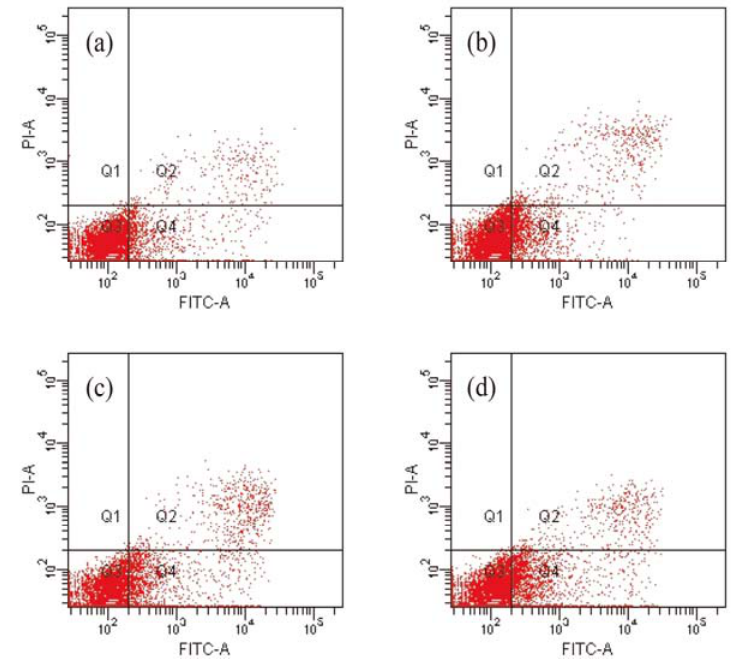
Figure 3. The fluorescence-activated cell sorter analysis for Annexin V/PI staining of HCT-8 cells treated with compound 1 . ( a ) Control, apoptotic rate 10.2%; ( b ) compound 1 1 μ M, apoptotic rate 14.4%; ( c ) compound 1 2 μ M, apoptotic rate 16.5%; ( d ) compound 1 4 μ M apoptotic rate